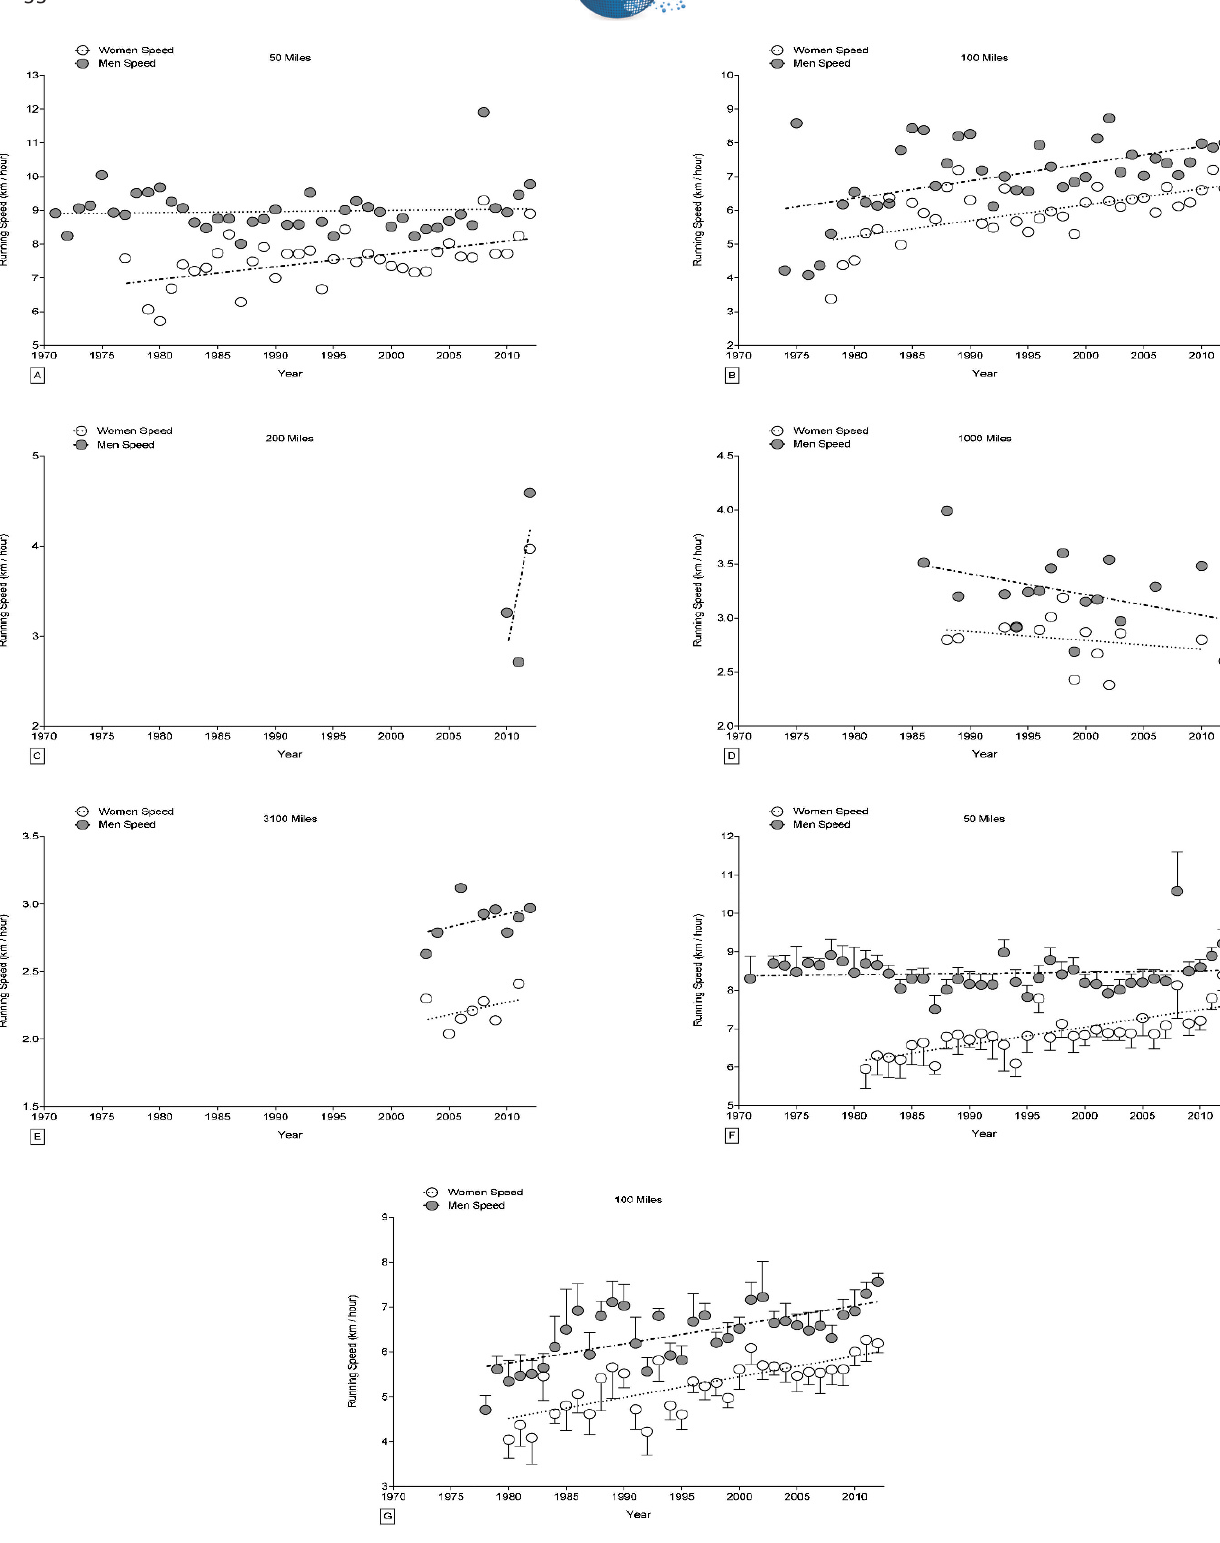
Figure 1 - Running speed over time of the annual fastest women and men for 50 miles (Panel A), 100 miles (Panel B), 200 miles (Panel C), 1,000 miles (Panel D), and 3,100 miles (Panel E) and for the annual ten fastest runners for 50 miles (Panel F) and 100 miles (Panel